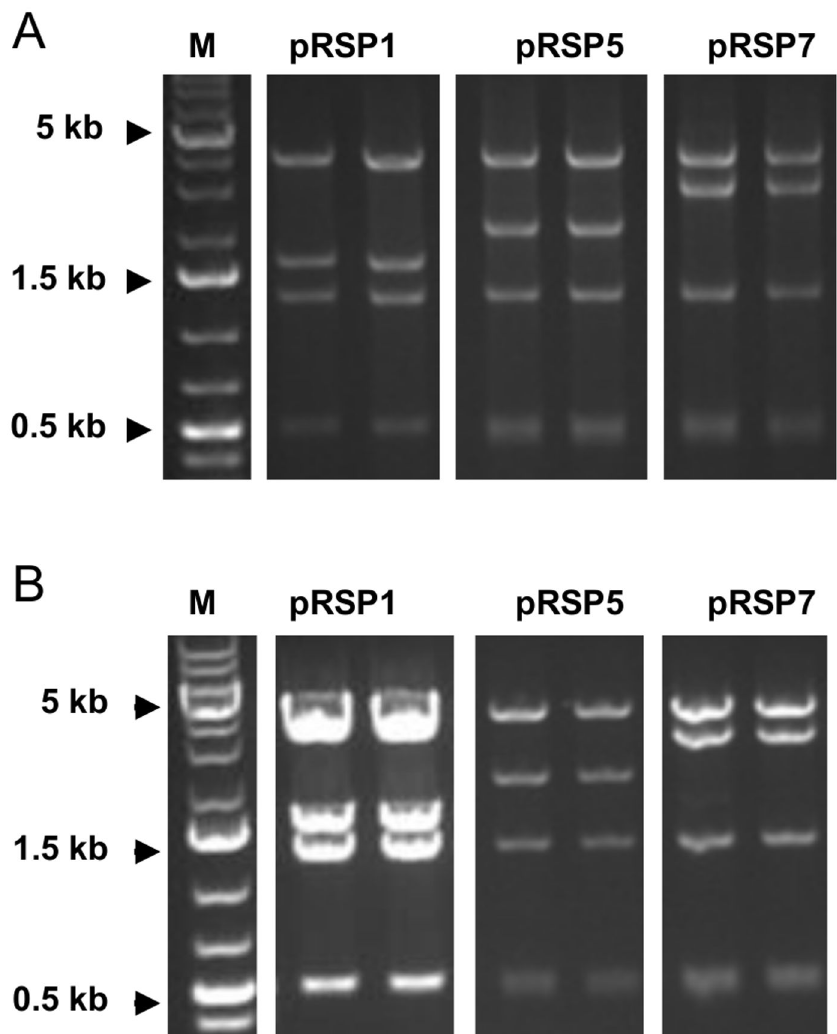
Figure 3. Extraction plasmids from S. acidocaldarius transformants and re-transformation into E. coli . (A) pRN1-based shuttle vectors were recovered from S. acidocaldarius transformants and re-transformed into E. coli to verify that the plasmids were self-replicating. The identity of the plasmids was confirmed by their EcoRI digestion finger-print. (A) EcoRI digestion finger-print of pRSP1, 5 and 7 recovered from (A) S. acidocaldarius E4-39 transformants and (B) E. coli re-transformed with plasmid DNA from the S. acidocaldarius transformants analyzed in (A).